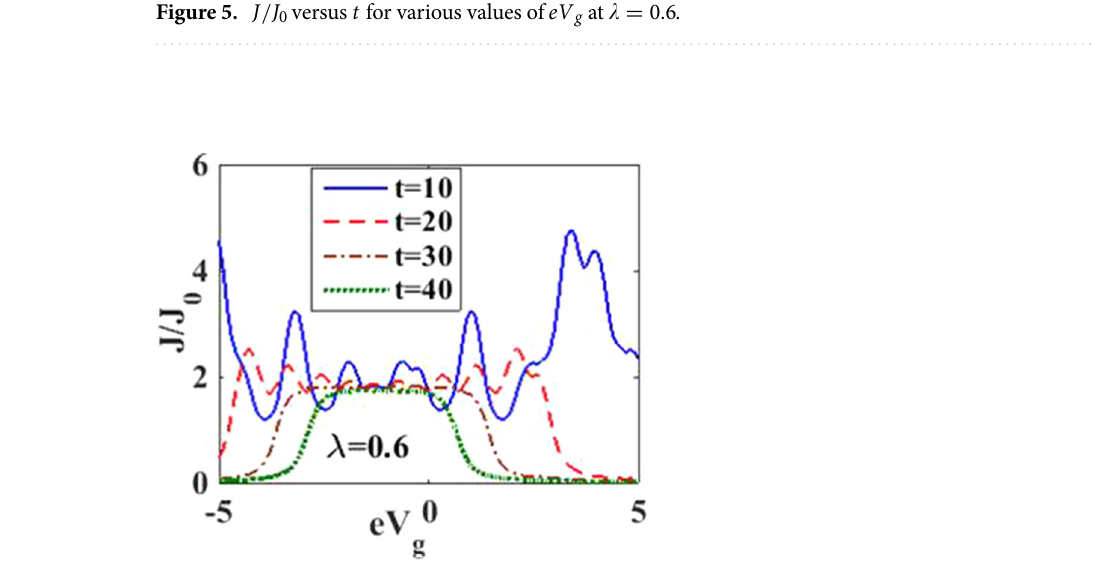
Figure 6. J / J 0 versus eV g for various values of time at eV b = 0.5